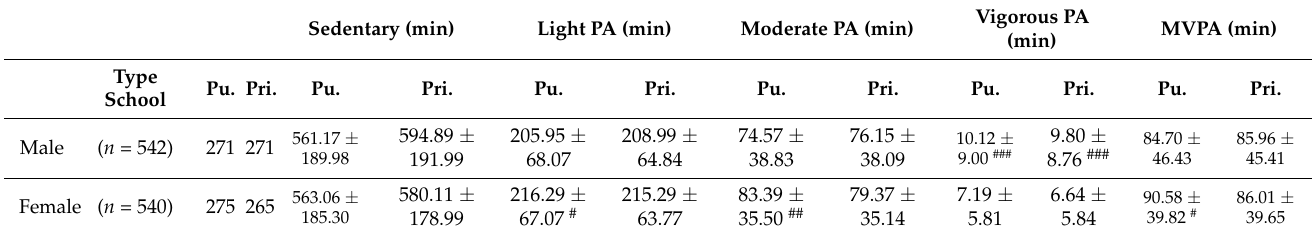
Table 7. Results of daily physical activity levels and sedentary behavior variables on the basis of centre ownership and sex as independent variables of